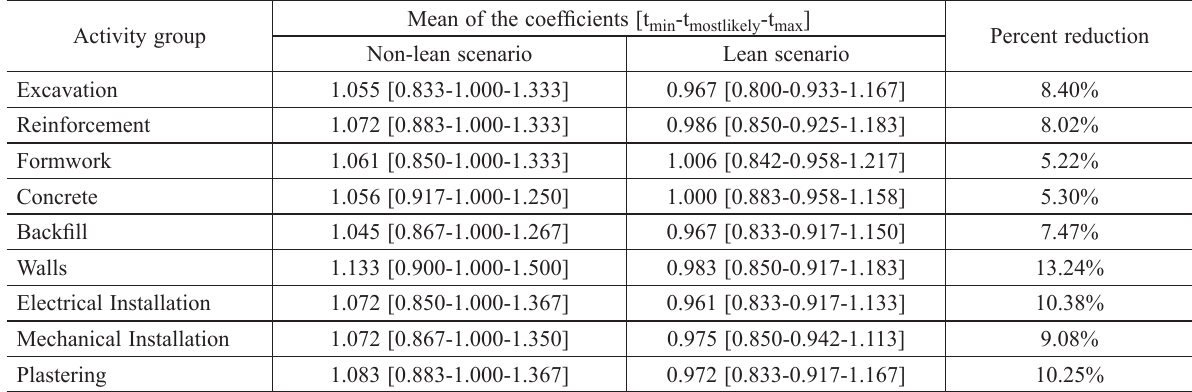
Table 6. Mean of the activity coefficients for both scenarios Activity